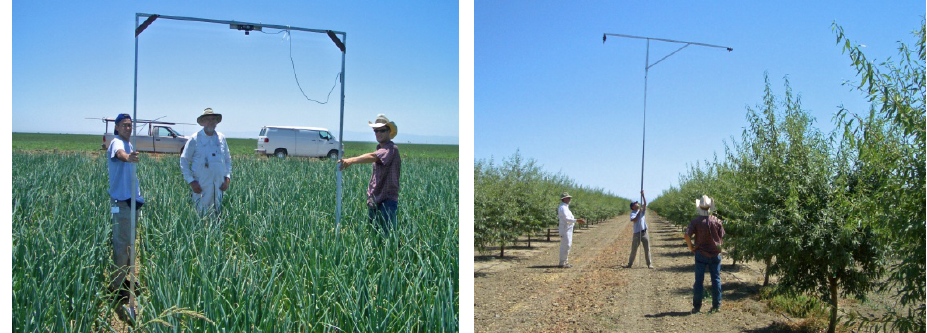
Figure 2. Measurement of green fractional cover (Fc) for low and high stature crops using multispectral